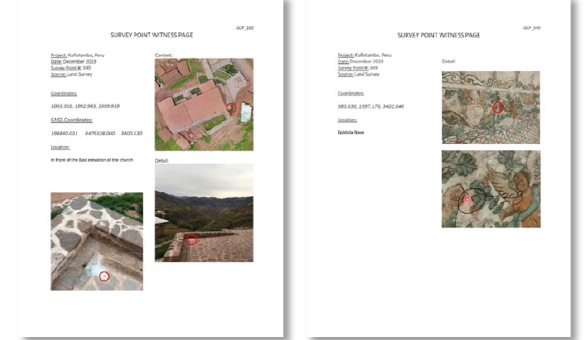
Figure 7 . Detailed terrestrial photogrammetry of the mural paintings in the area below the choir loft.